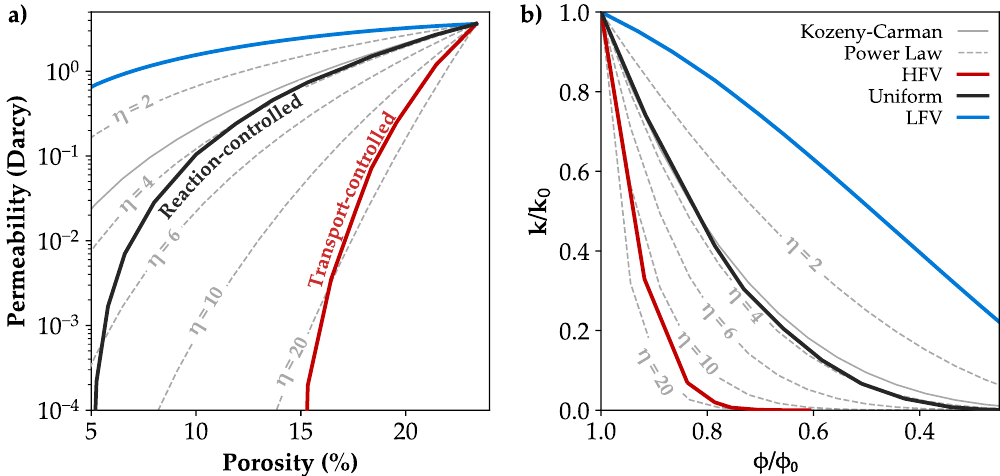
Figure 9. ( a ) Simulated permeability decrease due to preferential precipitation at high flow velocity magnitudes (HFV, red), low flow velocity magnitudes (LFV, blue) and independent of the fluid flow (black) compared to porosity-permeability estimates by the Kozeny–Carman (grey line) and the power law relations with different exponents η (dashed lines). ( b ) Porosity-permeability relations normalised to their initial